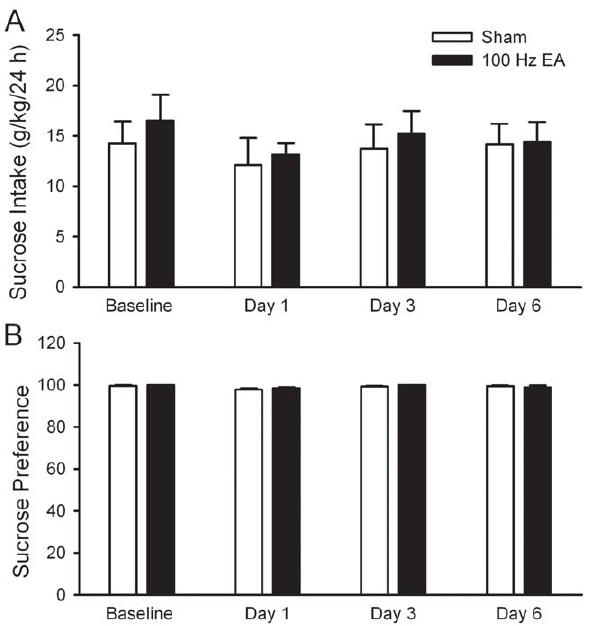
Figure 4. Multiple sessions of 100 Hz EA did not alter the intake of and preference for sucrose. Rats were trained to drink 5% sucrose solution under the intermittent access drinking procedure, similar to that for ethanol drinking. When rats had achieved a consistent baseline level, 100 Hz EA or sham were administered to rats for 6 consecutive days, 10 min before the start of sucrose- or water- drinking session. The effect was measured on day 1, 3, and 6. The values are expressed as mean 6 S.E.M. n=4 animals in each group.